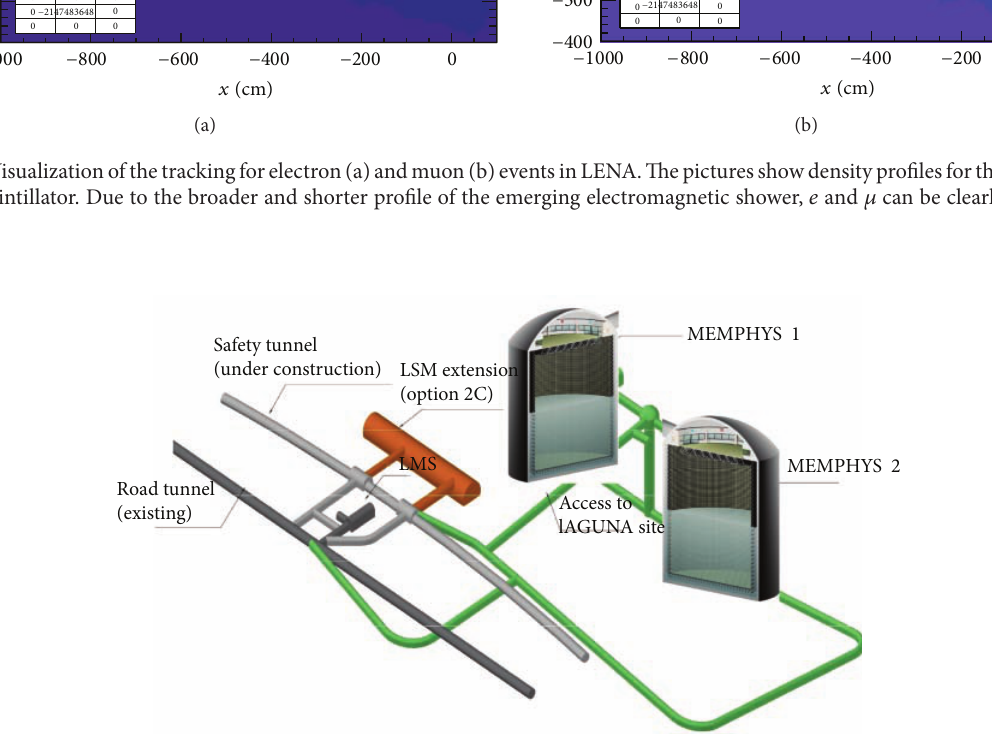
Figure 29: Possible layout for the future neutrino observatory at the Fr´ejus tunnel. The MEMPHYS detector is made of two independent tanks 60m apart from each other. Each tank is 65m in diameter and 103m in